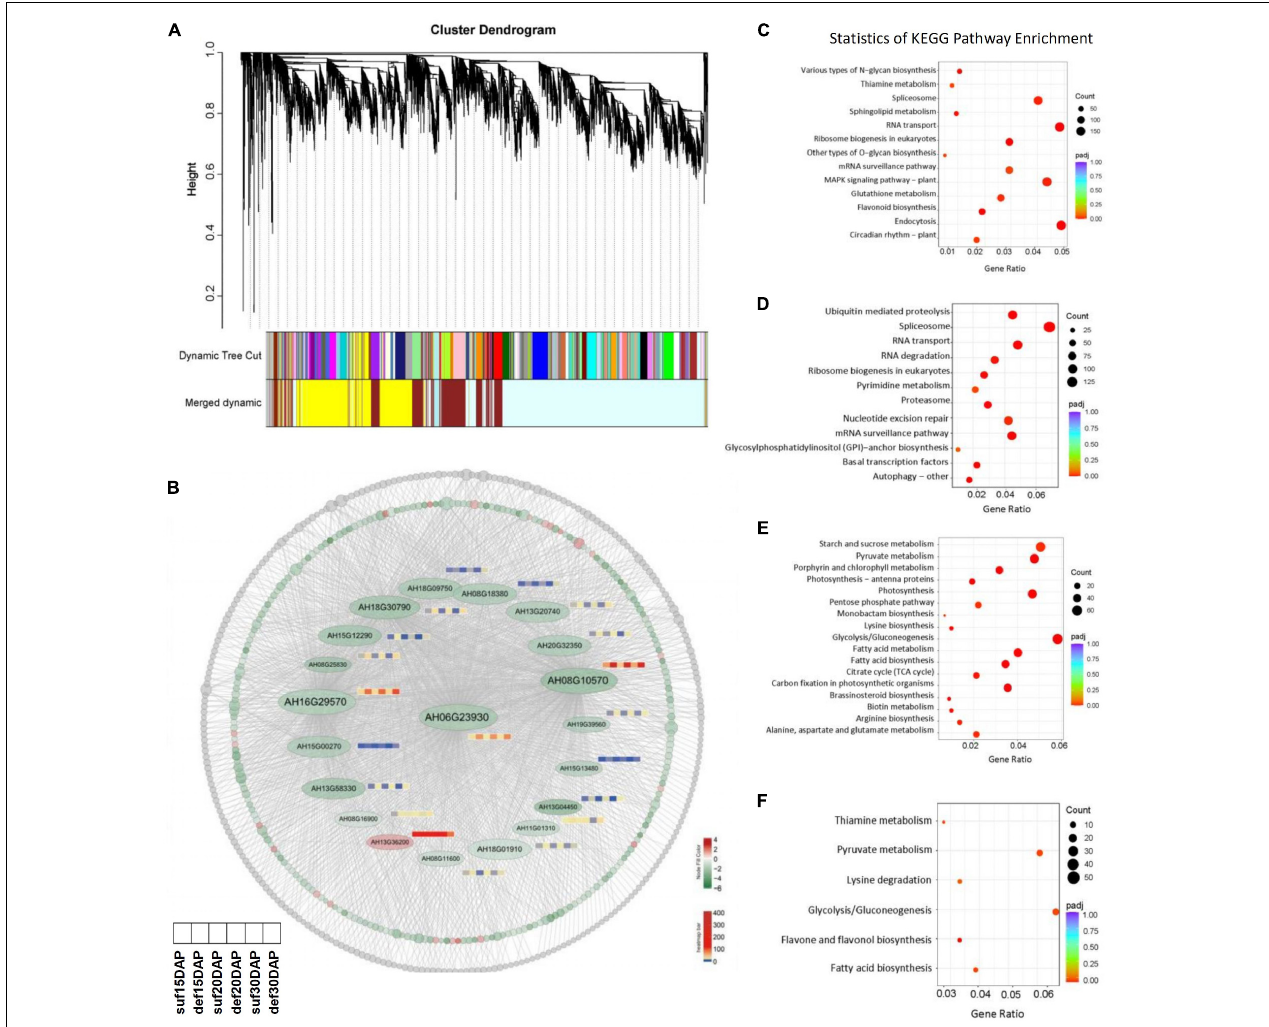
FIGURE 7 | WGCNA of the genes under calcium deficiency and sufficiency in peanut embryo at 15, 20 and 30 DAP. (A) Hierarchical clustering tree indicates 16 modules of co-expressed genes identified by WGCNA. (B) Network of the hub gene AhFUS3 (AH06G23930) and related genes with an edge weight of > 0.15 from the navajowhite2 module. Each circle represents one gene and red color indicates up-regulated genes, green indicates down-regulated genes, gray color represents the genes with no significant differences under calcium deficiency and sufficiency conditions. The expression profiles for important transcription factors in the navajowhite2 module under calcium deficiency and sufficiency conditions at the stage of 15, 20 and 30 DAP were analyzed. (C–F) KEGG analysis of genes in the darkolivegreen2, firebrick3, navajowhite, navajowhite2